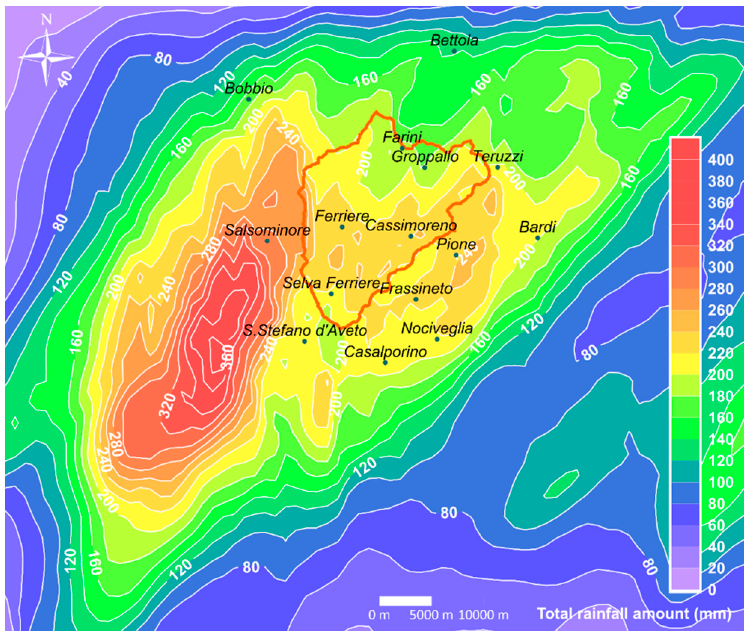
Figure 9. Isohyet map of total rainfall (mm) for the event of interest obtained through the radar reflectivity, linked to rain gauges on the Trebbia and Nure. In red the boundary of the Nure watershed closed at the Farini outlet.